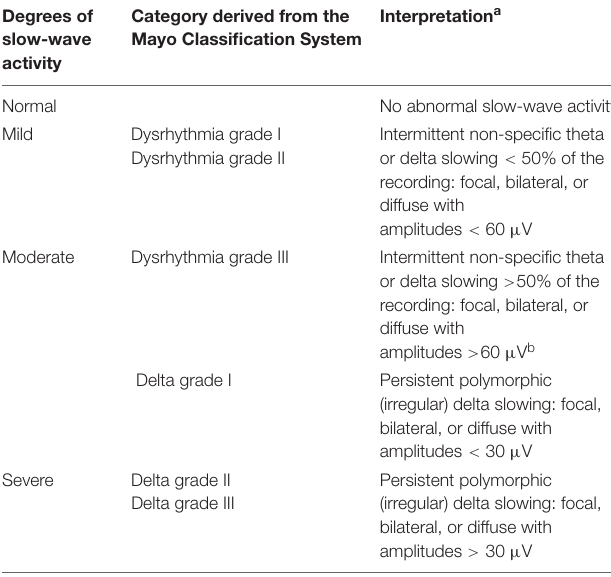
TABLE 2 | Classification of slow-wave activity in EEG by visual